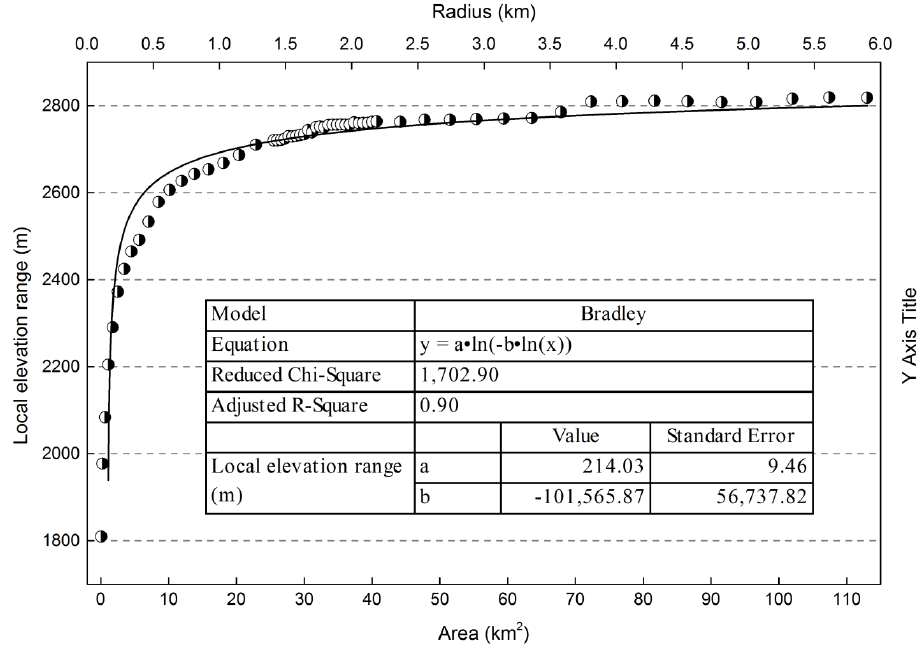
Figure 3. Local elevation range at different neighborhood scales (with different radii) in MSEA.